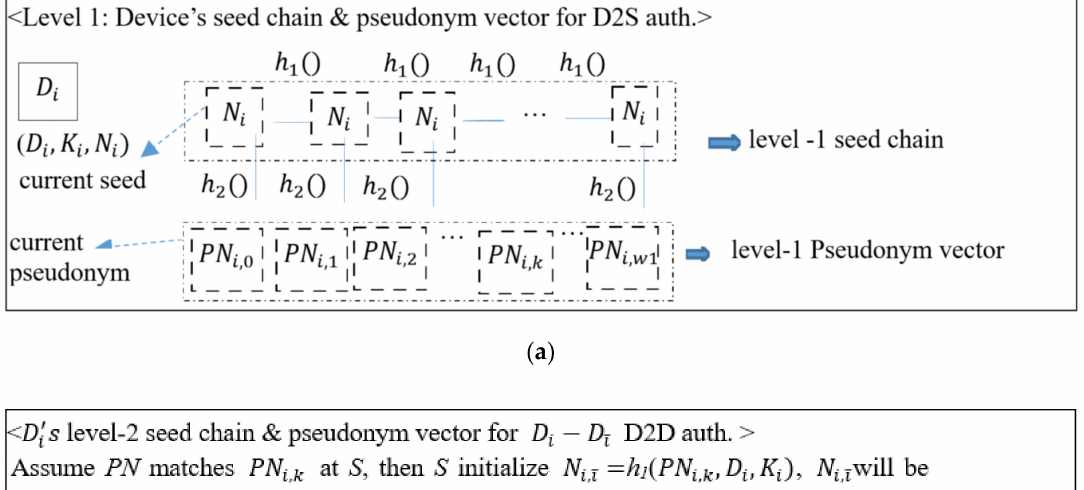
D2D authentication; ( c ) i